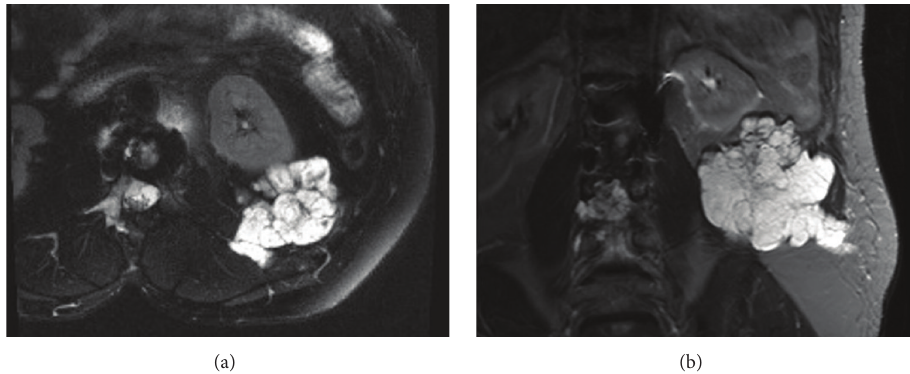
Figure 1: (a and b) Cross and Coronal sections MRI images show tumor recurrence with extension to psoas muscle.